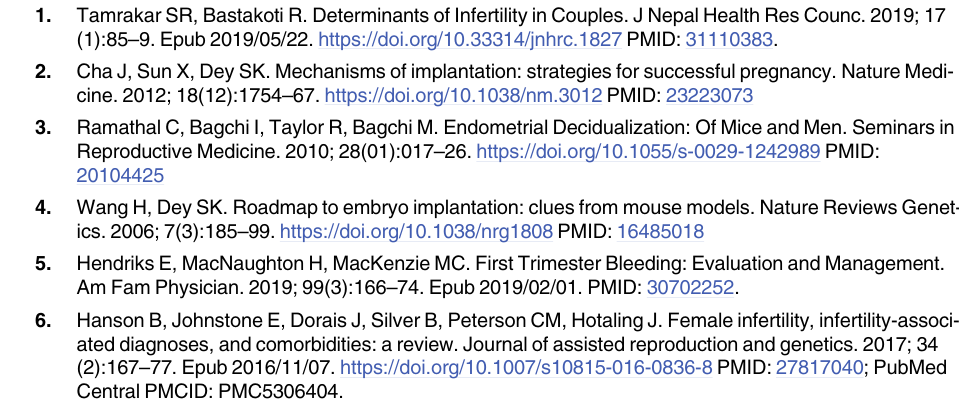
S11 Fig. The schematic flow chart about Shp2-mediated signal cascades including ERK-C/ EBP β , AKT-FOXO1, and JAK-STAT3. S1 Table. Primary antibody used in the assay of immunohistochemistry, Immunofluores- cence and western blotting. S2 Table. Primer sequences used for realtime